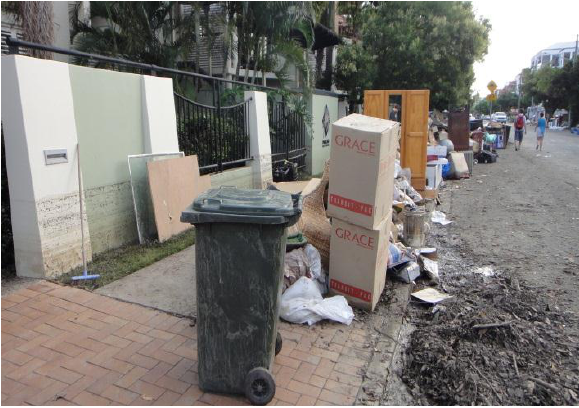
Figure 2. Volunteered image taken 14 January 2011 After the site was located from the image and supporting